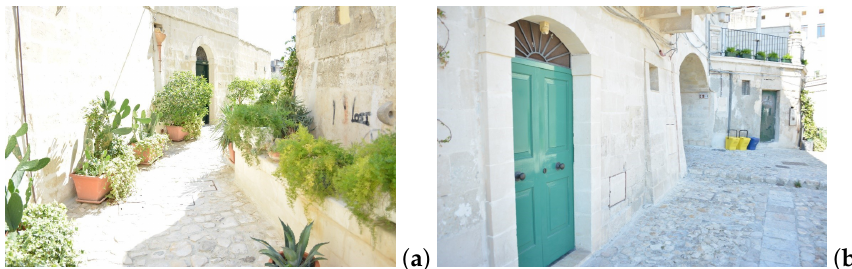
Figure 1. Two examples of the 1937 photographs used as input in RealityCapture software for the 3D reconstruction of an alley in Sassi of Matera. ( a ) A perspective from the entrance of the alley. ( b ) A perspective from the end of the